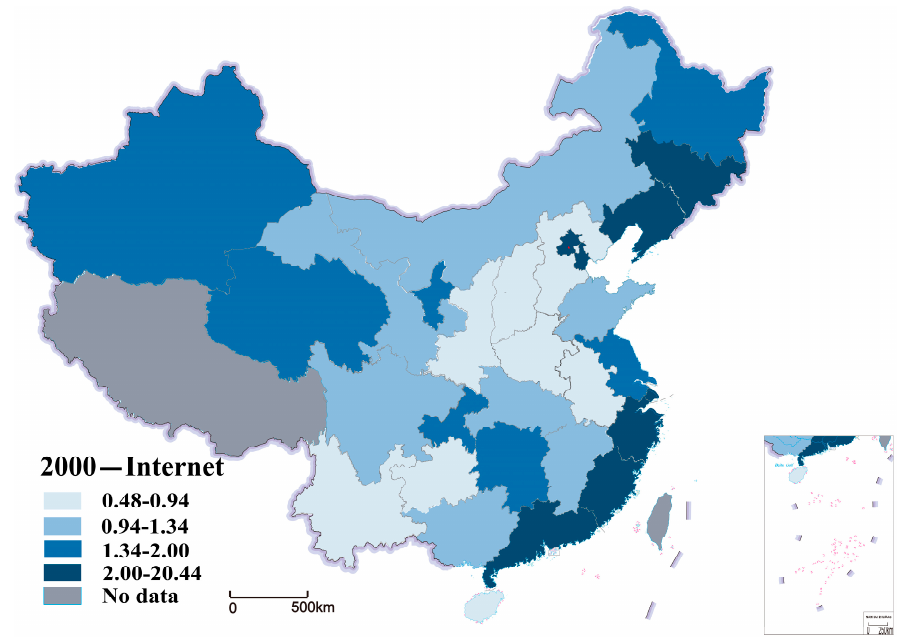
Figure 4. Distribution of Internet development in 2000.